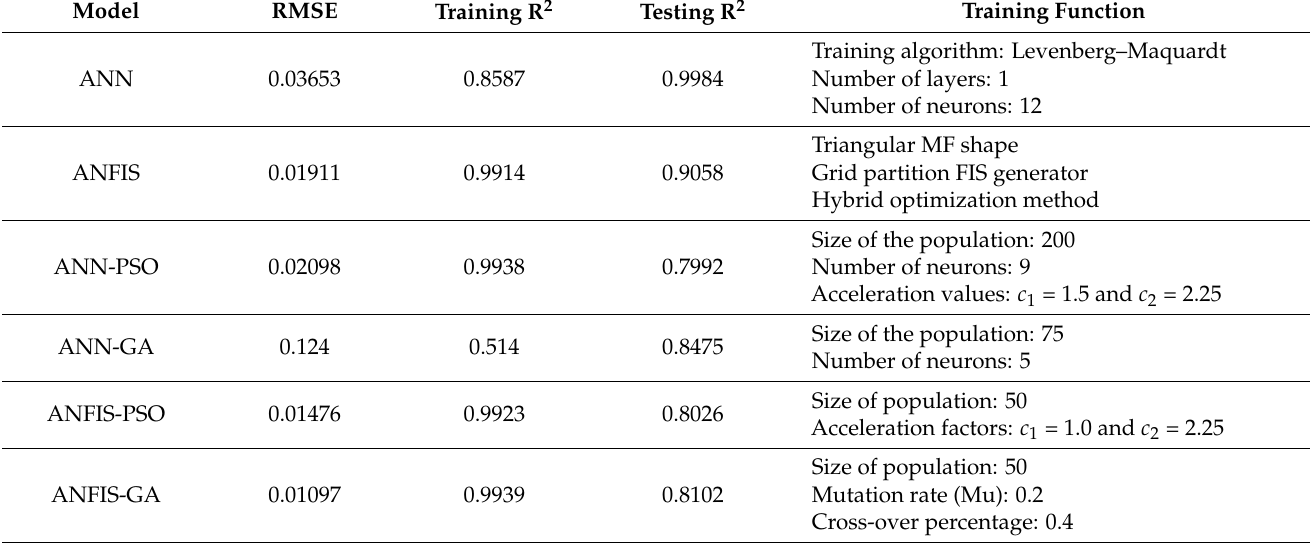
Table 9. Results